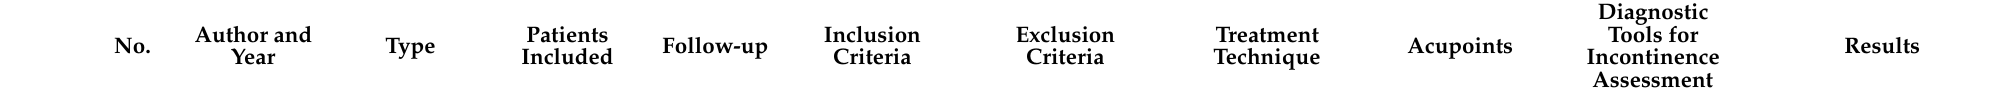
Table 1. Summary of reviewed publications on fecal incontinence treated with